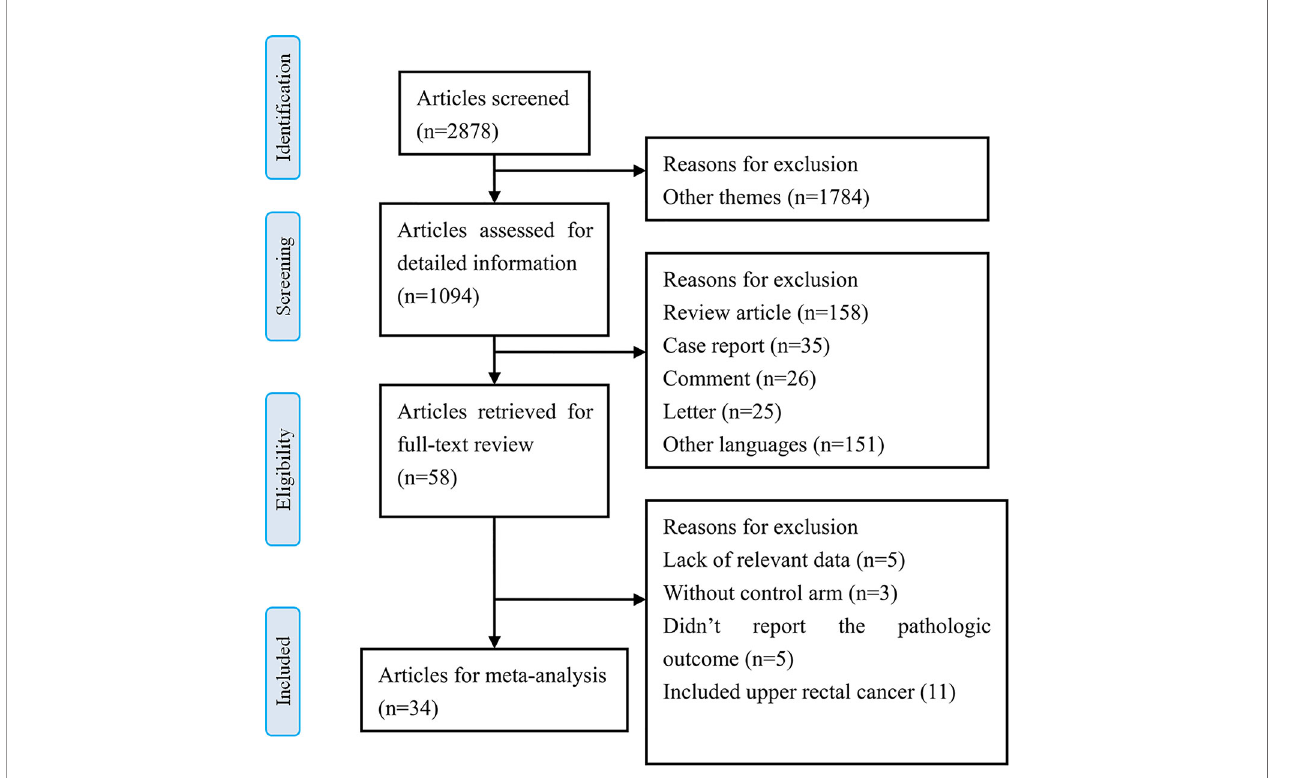
FIGURE 1 | Flow chart for the literature search and study